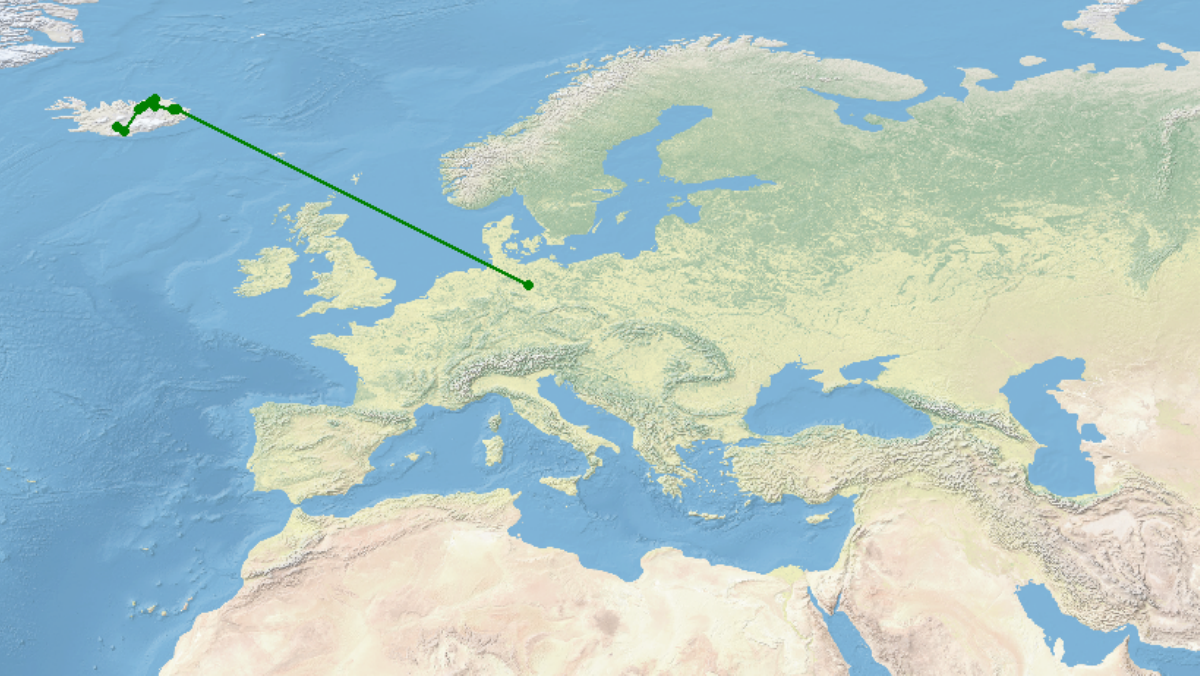
Figure 9. Individual track of Diaptomus rostripes.